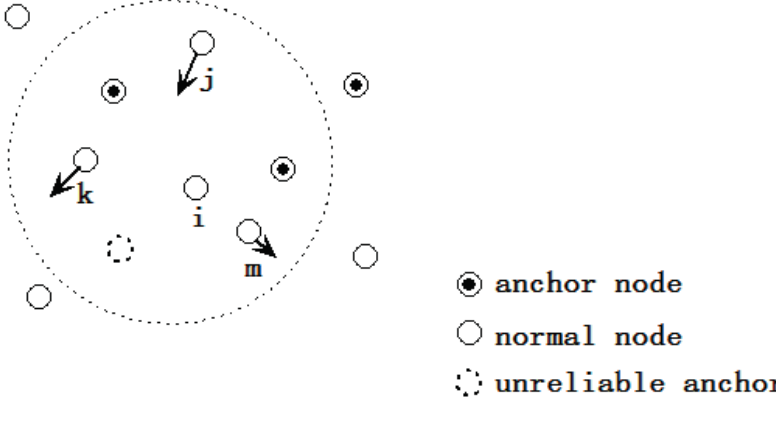
Figure 5. Temporal anchor